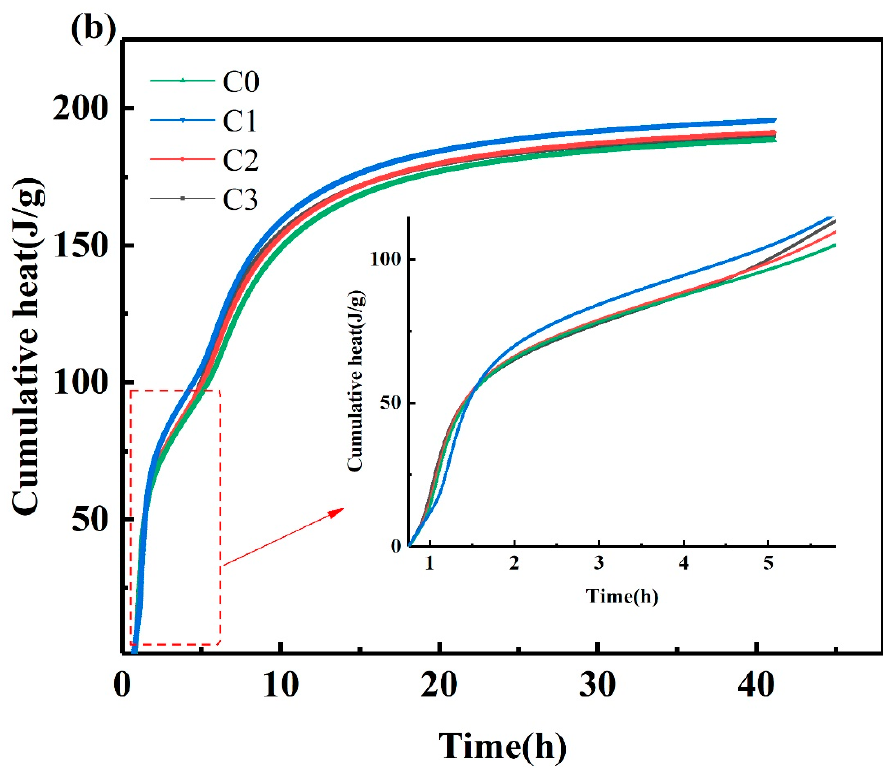
Figure 5. Hydration heat: ( a ) hydration flow; ( b ) cumulative heat.